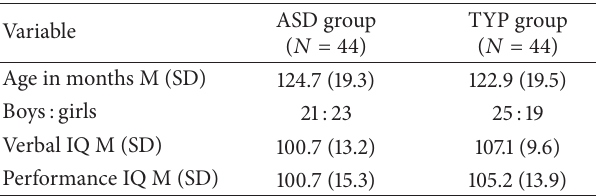
Table 1: Demographic characteristics of the Autism Spectrum Disorder and typically developing groups.